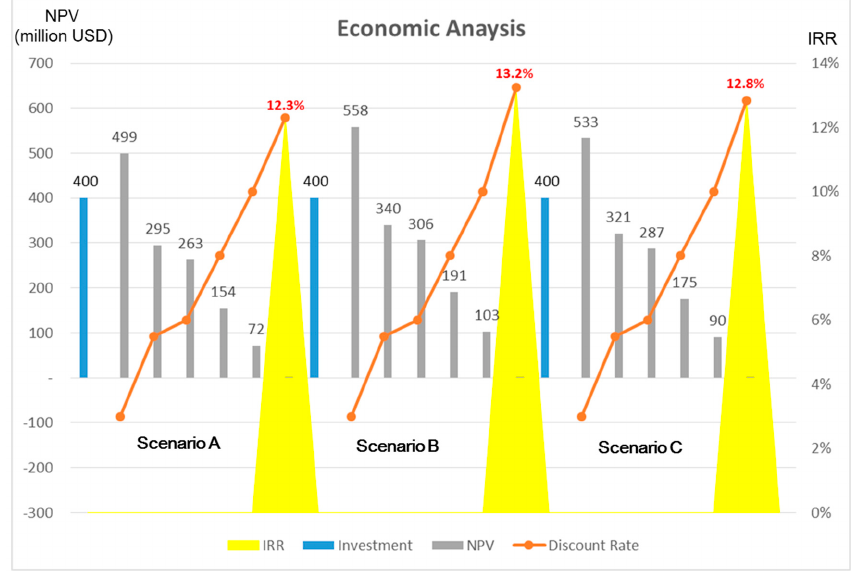
Figure 11. Effect of NPV & IRR on investment and discount rate for all scenarios.